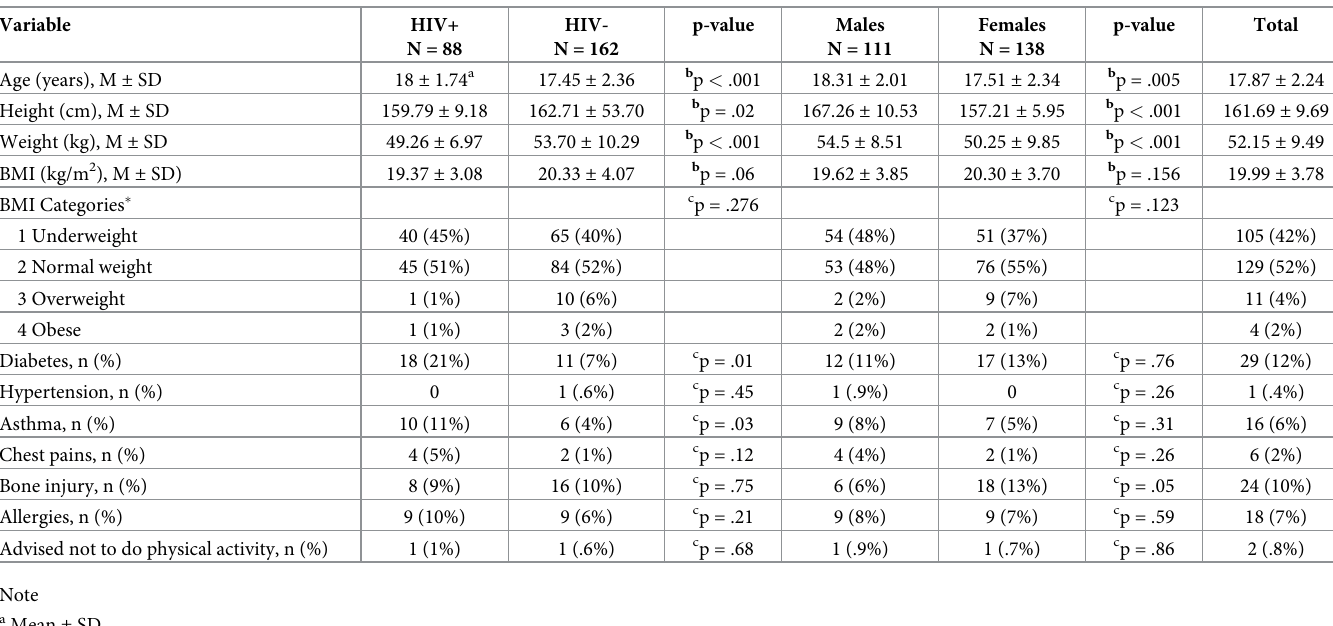
Table 1. Demographic and health characteristics by HIV status and by sex . Variable